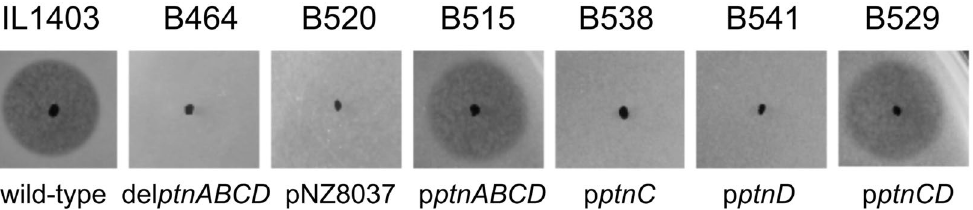
Figure 3. Sensitivity of the L . lactis clones to garvicin Q. IL1403 (wild-type strain), B464 ( ptnABCD deletion strain), B520 ( ptnABCD deletion strain expressing empty pNZ8037 plasmid), B515, B538, 541, B529 ( ptnABCD deletion strains expressing ptnABCD , ptnC , ptnD and ptnCD ,